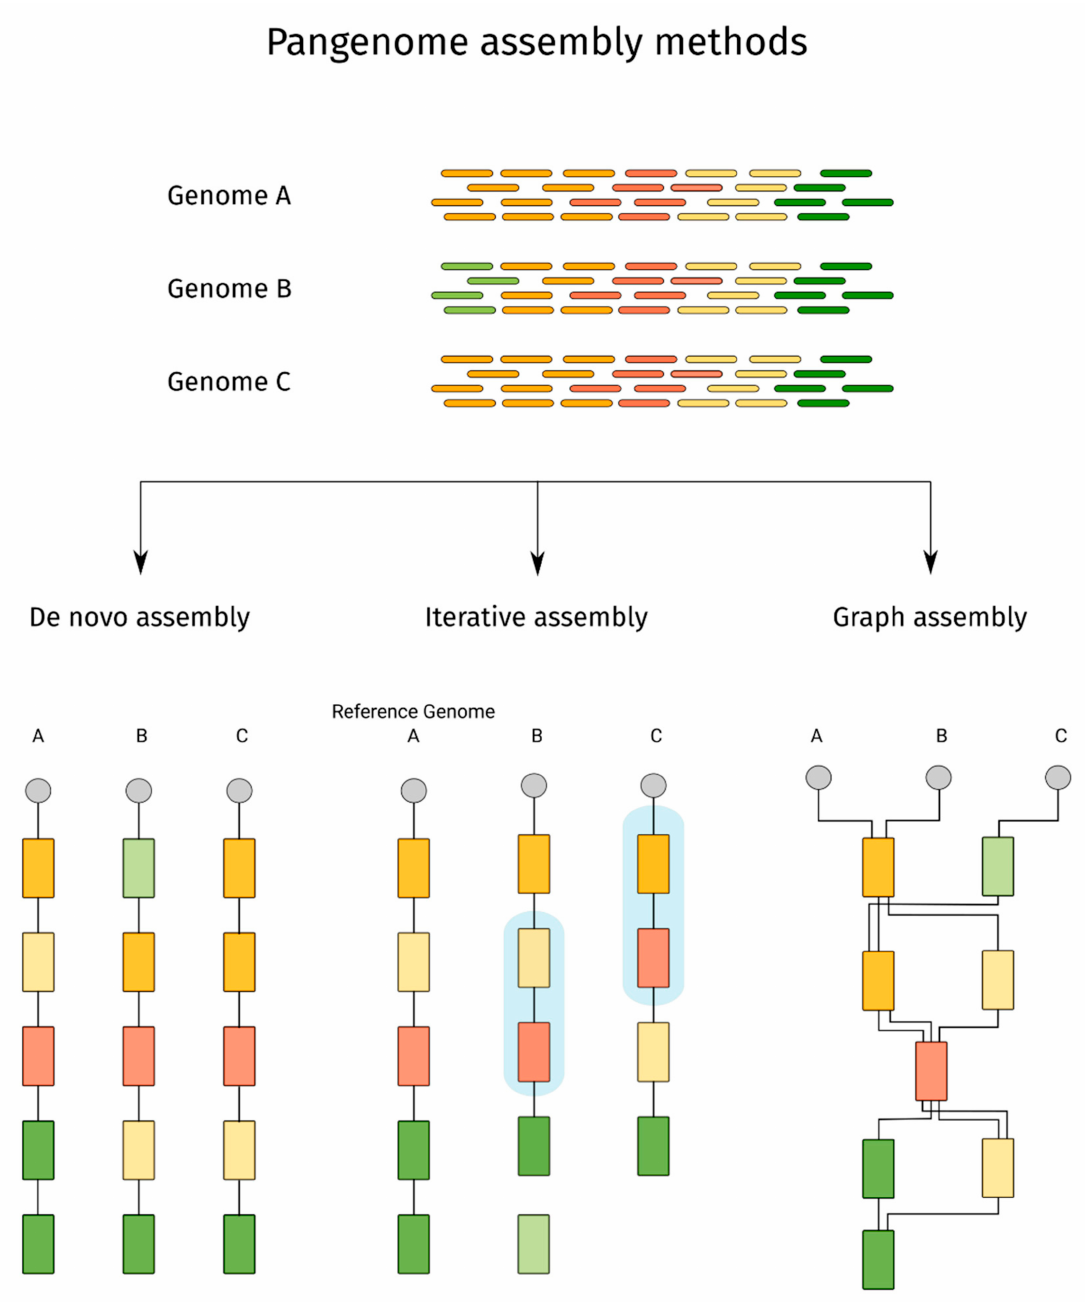
Figure 1. Scheme showing three pangenome assembly methods. Sequence reads from genomes A, B and C can be used to assemble the species pangenome using de novo method yielding three separate genomes that will be compared to define the core and variable regions. In the iterative assembly, genome A is assembled de novo and used as a reference for assembling the remaining genomes B and C. Because genome A has different genes from genome B and C, it may change the gene order in genome B (highlighted in the blue box) or collapsing CNV in genome C (highlighted in the blue box). In the iterative assembly, genes not represented in the reference genome (genome A) have to be assembled de novo and may lose their location information as shown by the green gene below genome B assembly. Graph pangenome assembly of genomes A, B and C represent the genes as interconnected nodes, each path representing a